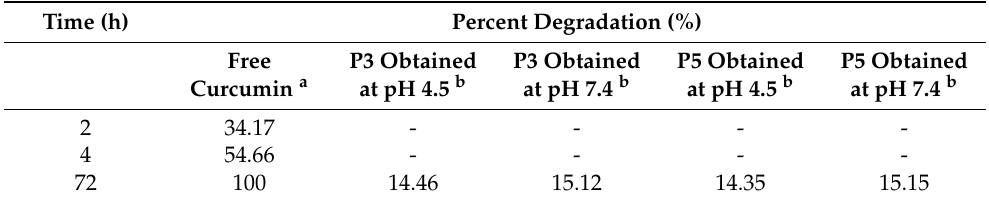
Table 3. Photodegradation of curcumin versus its P3- and P5-complexes.